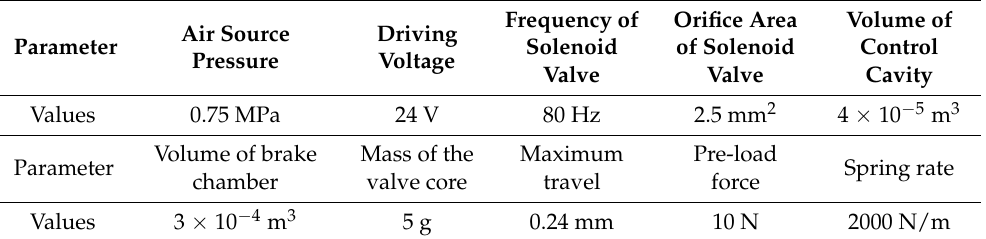
Table 1. Parameters of the co-simulation model for the LF-APRV and dynamic PWM coupling pressure regulation method.